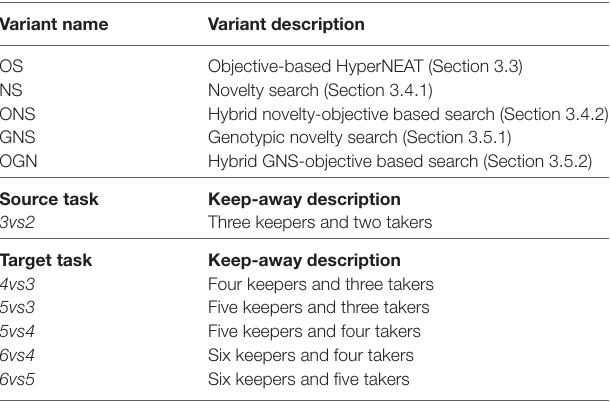
TaBle 1 | HyperNEAT variants for evolving keep-away behavior in the source task.